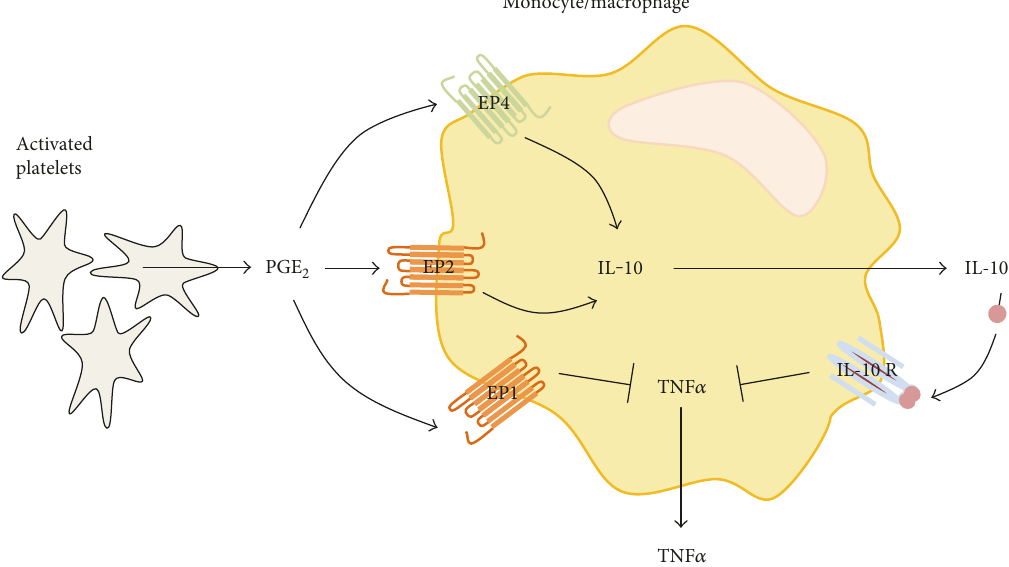
Figure 9: Summary of the platelet-induced crosstalk between PGE , IL-10, and TNF α in murine macrophages and human monocytes. 2 Activated platelets produce and release PGE in cocultures with macrophages. PGE binds to EP1, EP2 (orange), and in case of murine 2 2 macrophages additionally to EP4 (green). The binding of PGE to EP1 decreased synthesis and secretion of TNF α independently of IL-10. 2 The activation of EP2 and EP4 in murine macrophages and EP2 in human monocytes increased the secretion of IL-10 which binds to its receptor IL-10 R, leading to an inhibition of the production and release of TNF α